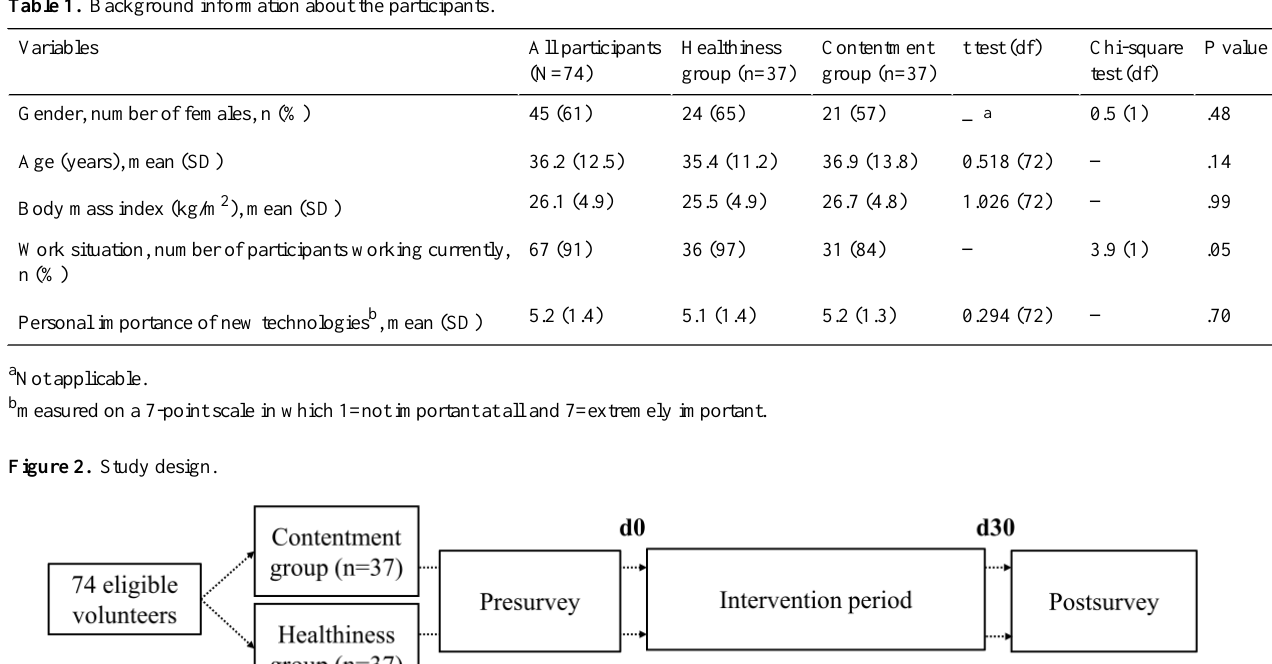
Table 1. Background information about the participants.